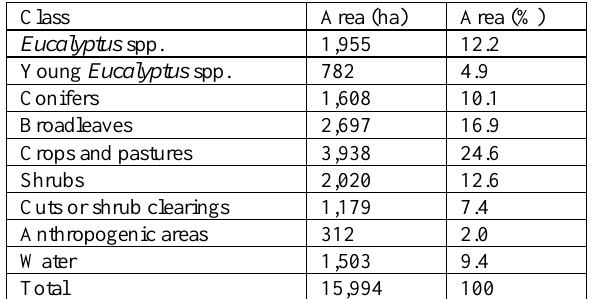
Table 5. Area covered by each general class according to the general classification.